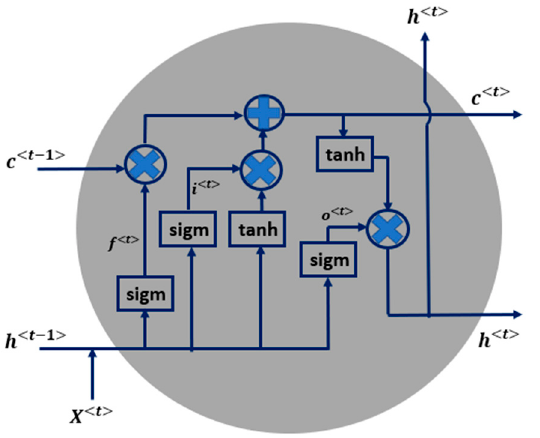
Figure 3. Illustration of long short-term memory (LSTM) unit, having three gates and a memory cell state.